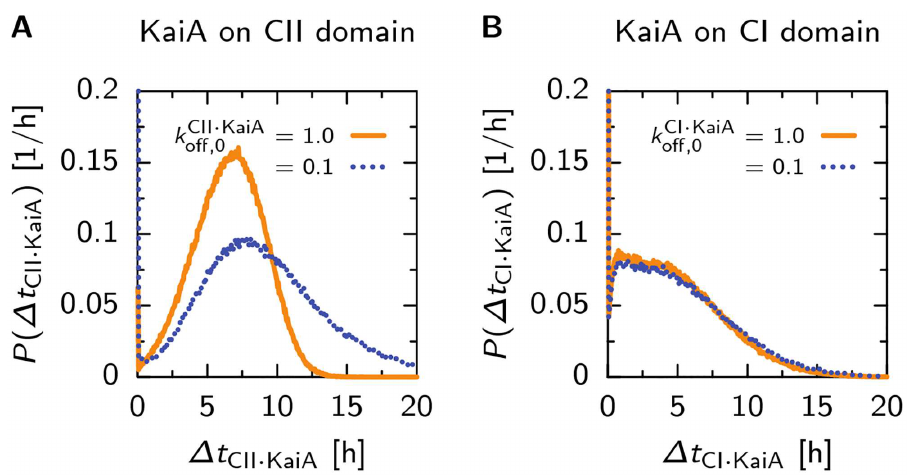
Fig 12. Probability density of the time, per period of the phosphorylation cycle, the CII domain of a KaiC hexameris bound to KaiA, Δ t CII (cid:1) KaiA . (A), or the CI domainhas at least one KaiA dimer bound, ¼ 1 : 0 Δ t CI (cid:1) KaiA (B). We compare situationswith our standardvalue for the KaiA dissociationrate, k CII (cid:1) KaiA off ; 0 ¼ 0 : 1 (blue dotted line). (A) For the CII domain, both (orangesolid line) with a much lower value k CII (cid:1) KaiA off ; 0